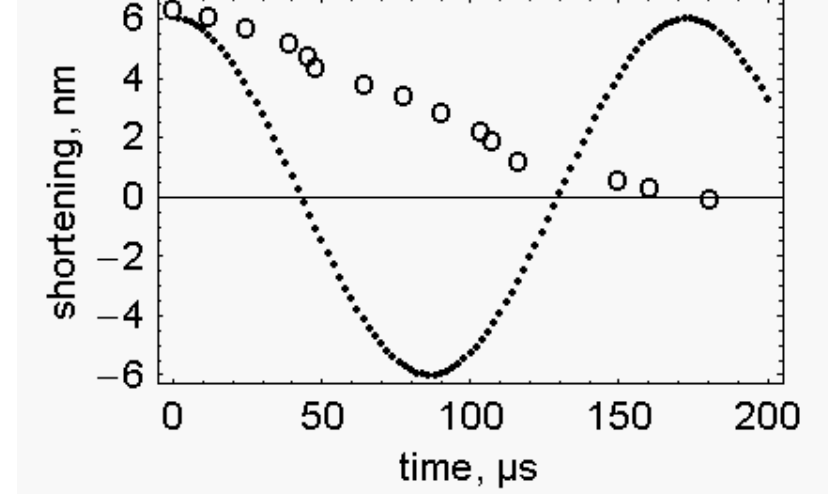
Figure 1. Time course of the quick release – Observed change of length during a quick release of 6 nm/half sarcomere (open circles), taken from Figure 14 of Ford et al . [2]. Calculated, spontaneous change of length during the same release (filled circles). The conditions used for the calculation were those of Figure 14 of Ford et al . [2]: P m 2 ; fibre length, 5.34×10 -3 m; fibbre section, 1.89×10 -8 m 2 ; fibre density (corrected for the